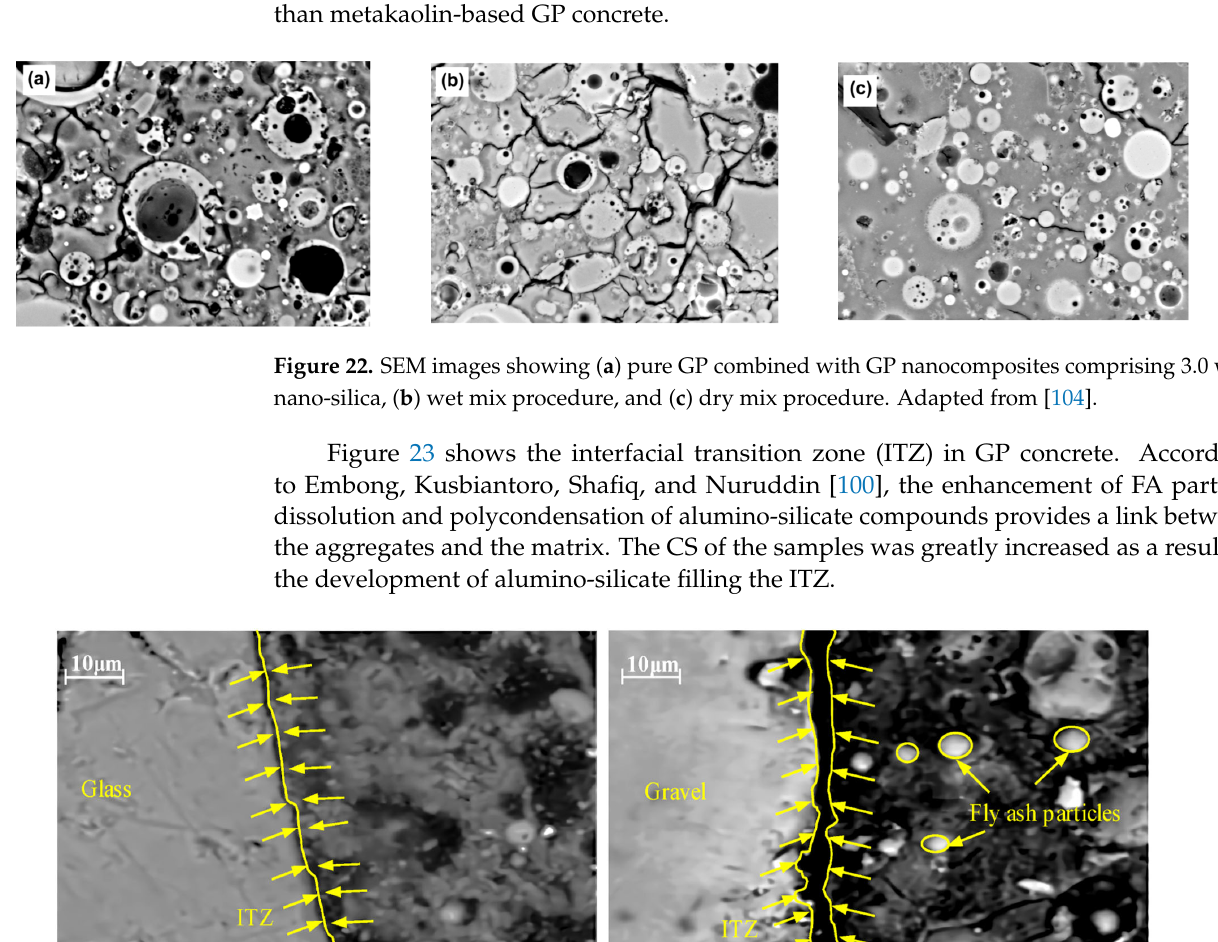
Figure 23. FA ‐ GP concrete SEM images with several types of aggregates: ( a ) the interface of the glass aggregate and GP; ( b ) the interface of the sand aggregate and GP. Adapted from [258,259].